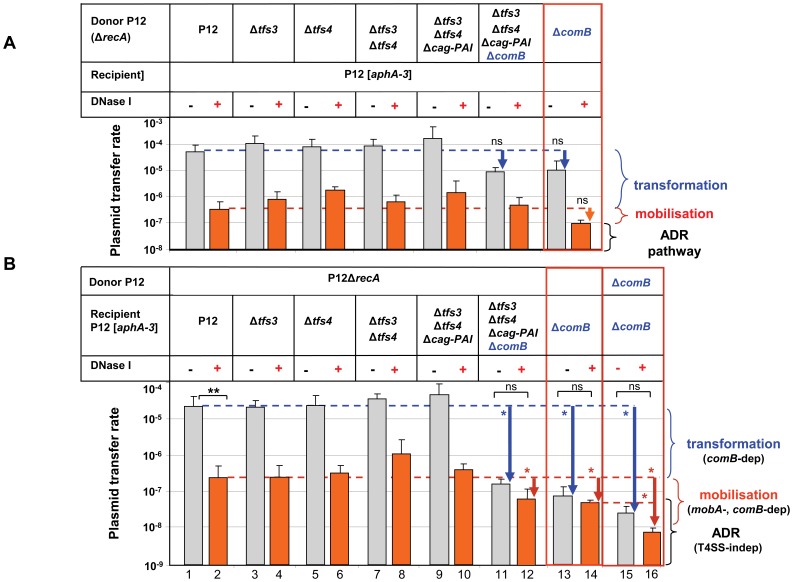
Only the comB but no other T4SS in the donor and recipient is involved in conjugative plasmid DNA transfer between H. pylori strains.(A) DNA transfer experiments of plasmid pHel12::cat were performed from a P12ΔrecA donor strain carrying complete marker-free deletions (rpsL-erm counter-selection procedure) of one or several T4SS into a wild-type P12 recipient strain in the absence (−) or presence (+) of DNaseI. The donor strain carries a recA deletion to render it non-transformable. As recipient strains, a P12 wild-type strain was used carrying a ΔmoeB(HPP12_765)::aphA-3 insertion conferring kanamycin resistance. Growth of chloramphenicol/kanamycin double-resistant clones indicated a unidirectional transfer of plasmid pHel12::cat to the recipient strains. (B) DNA transfer experiments of plasmid pHel12::cat from a wt P12ΔrecA donor into different P12 recipient strains carrying precise marker-free deletions of one or several T4SSs. Transfer rates were determined as the number of transconjugants/cfu/ml. Data shown are mean values of at least three independent experiments including standard deviations. Blue and red vertical arrows indicate the reduction in transformation and DNaseI-resistant plasmid DNA transfer rates, respectively. Data shown are mean values of at least three independent experiments including standard deviations. *, p<0.05; **, p<0.01, ns, not significant (p>0.05) according to students t-test. P12Δtfs3/Δtfs4/Δcag-PAI/ΔcomB is also refered to as P12ΔT4SS.